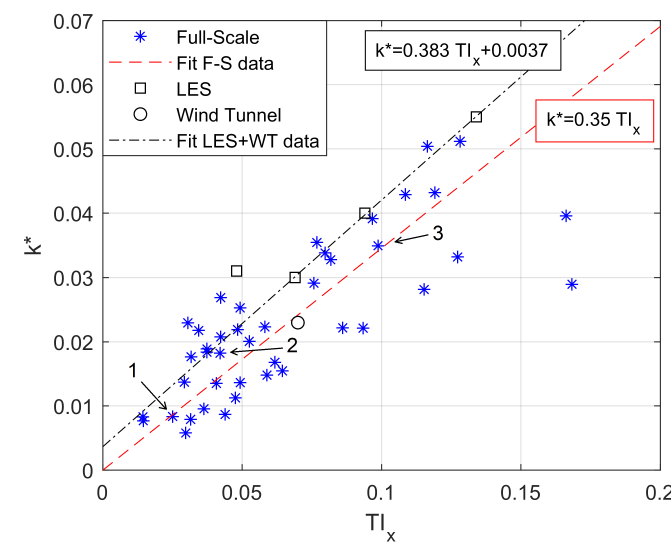
Figure 10. Relationship between wake growth k ∗ and longitudinal turbulence intensity TI x . In blue all the data collected during the experiment, in dashed red the linear fit to the full-scale field data presented in Equation (16). In black the data obtained from [11] and the linear fit used in [38]. Numbers 1 to 3 indicate the cases presented in Figure